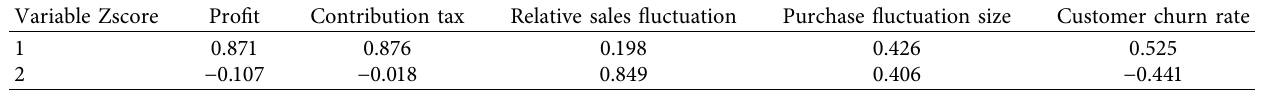
Table 1: Component score coefficient matrix.